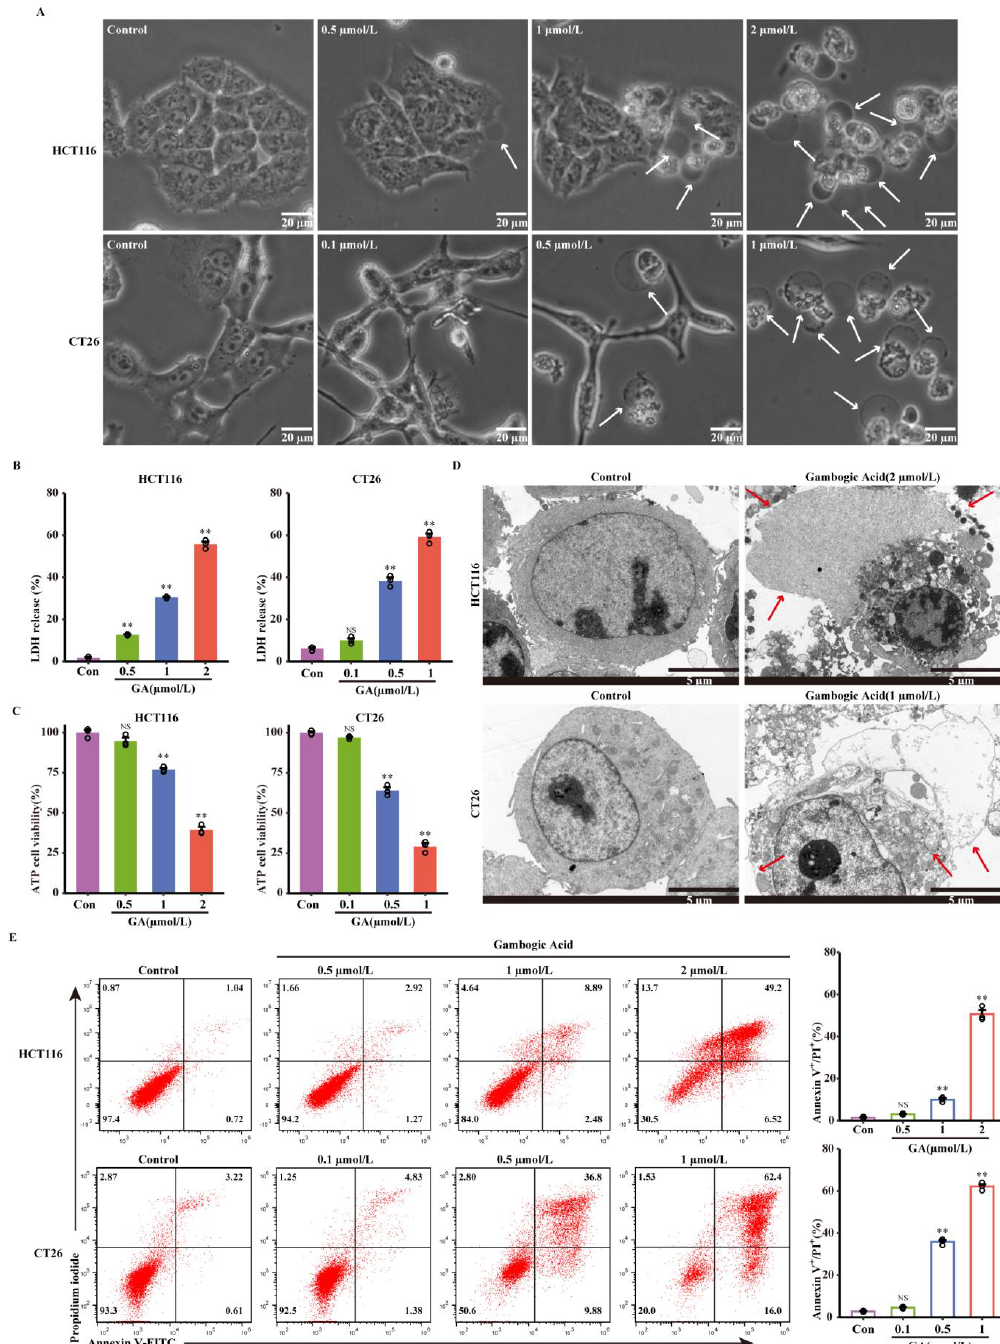
Figure 2. GA triggered cell pyroptosis in CRC cells. ( A ) Representative bright-field images of HCT116 and CT26 cells treated with GA for 12 h. The white arrows point to pyroptotic cells. Scale bar: 20 μm. ( B ) The release of LDH and ( C ) ATP cell viability after treatment with GA for 12 h. ( D ) Representative transmission electron microscopy images of HCT116 and CT26 cells treated with GA (2 μmol/L or 1μmol/L ) for 12 h. The red arrows indicate the large bubbles, cell membrane breaks, and organelle edema. Scale bar: 5 μm. ( E ) Flow cytometric analysis of HCT116 and CT26 cells treated with GA for 12 h. The cells were exposed to 0.1% DMSO as control. All experiments were repeated three times and results were expressed as mean ± SD. Con, control. NS, not significant, ** p < 0.01 vs.